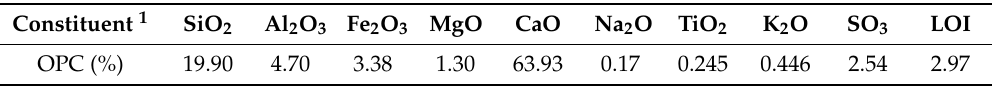
Figure 1. Secondary electron micrographs (JEOL 7001F FEGSEM at 15 keV) of the as-delivered carbon nanotubes (CNTs). ( a ) A 10,000 × magnification showing the heavily agglomerated CNTs. ( b ) A 100,000 × magnification showing the morphology of the entangled CNTs prior to dispersion. Table 1. Chemical properties and loss on ignition of the Australian type general purpose (GP) cement, complying with AS 3972–2010